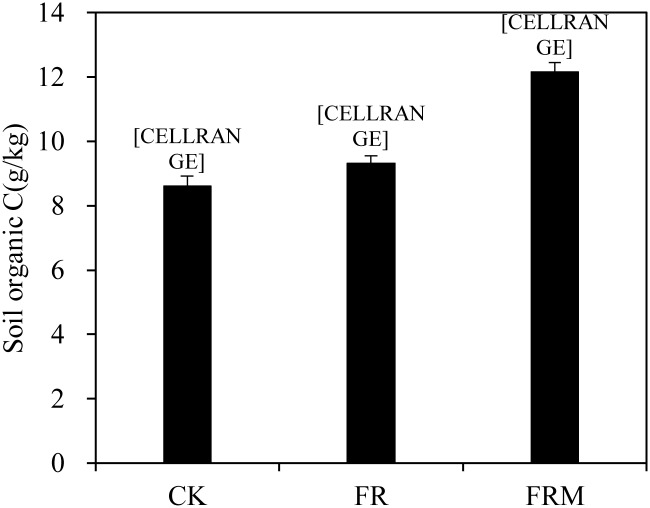
Compost and inorganic fertilizer effects on the organic C content in the soil.Vertical bars denote the standard error of the mean (n = 3). Different letters a, b and c indicate significant differences between treatments at P < 0.05.